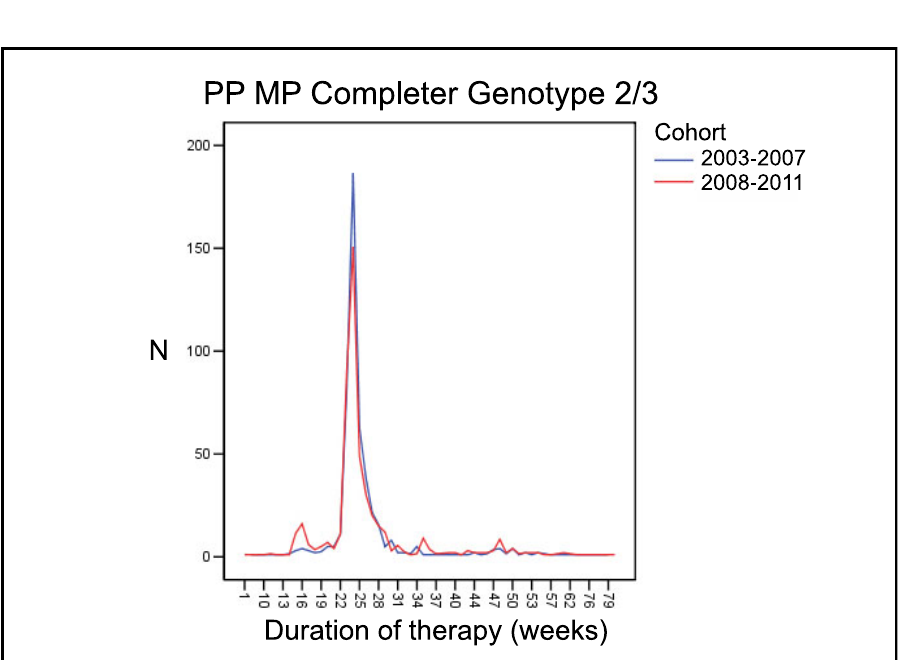
Fig 3. Comparison of treatment duration in patients infected with genotype 2/3 between 2003 – 2007 and 2008 – 2011 period. MP, matched pairs; PP, per protocol.